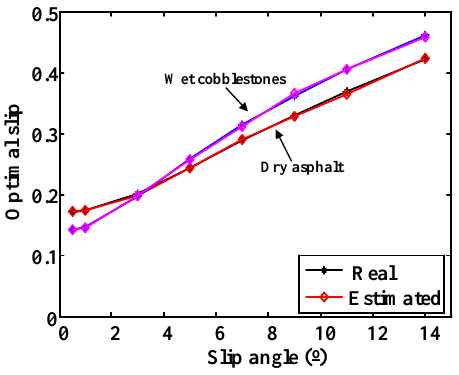
Figure 9. Comparison between the real optimal slip and the optimal slip provided by the ANN.